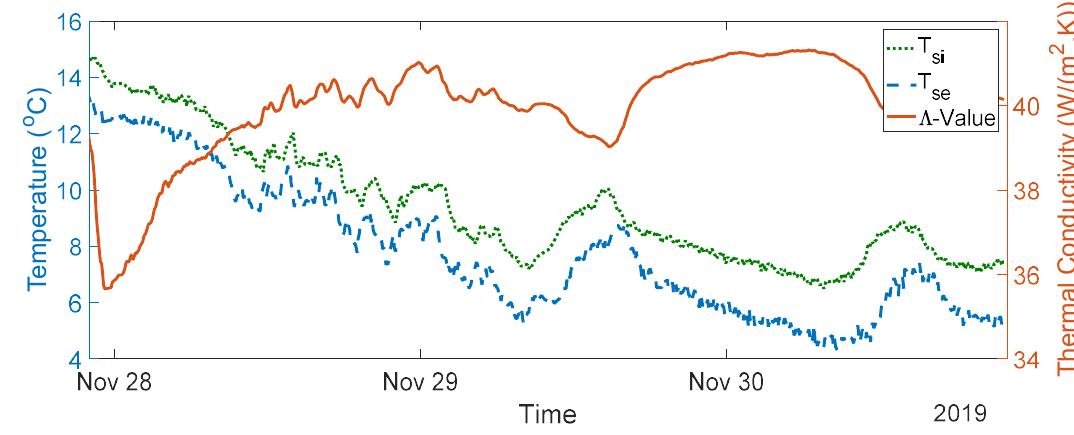
Figure 12. Thermal conductivity measurement data from Day 1 to Day 3.